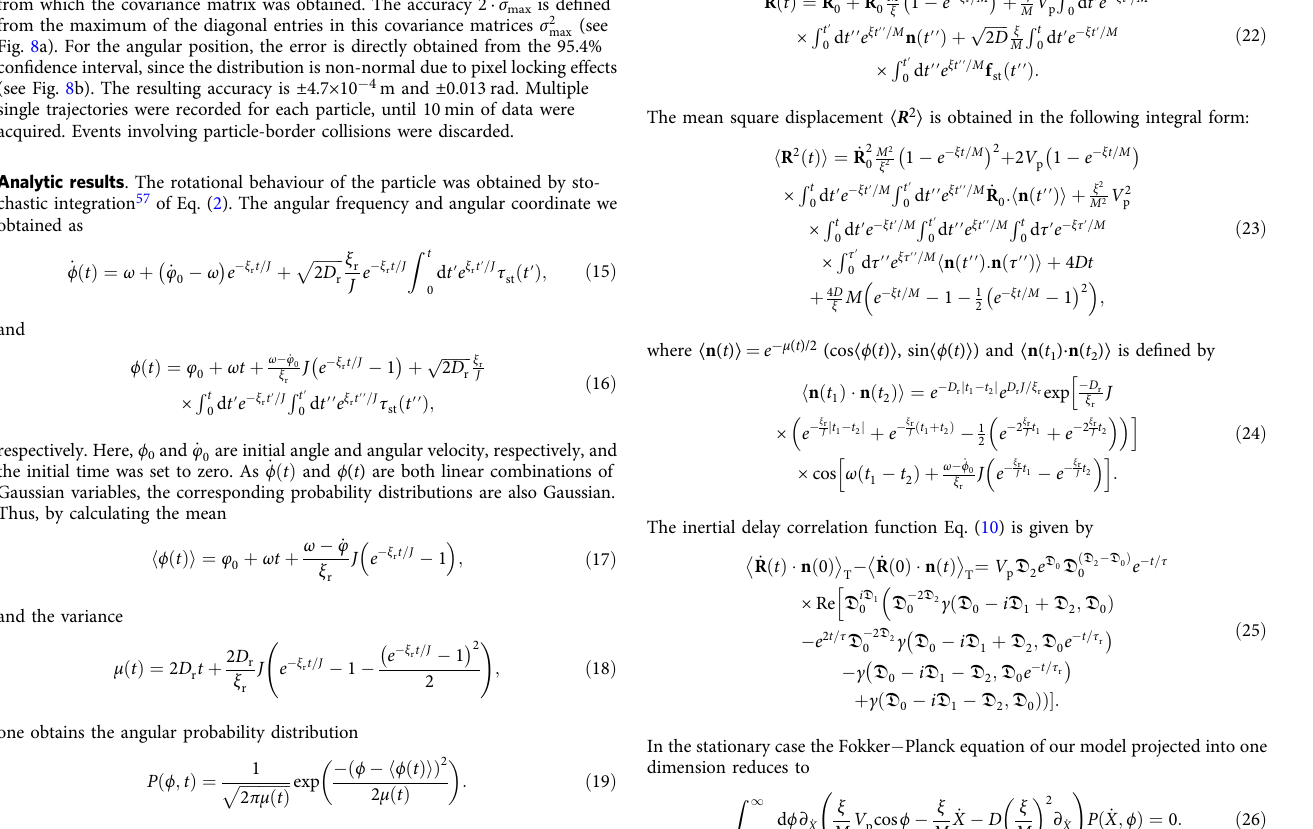
Experimental setup . The vibrobots were excited by vertical vibrations generated by a circular acrylic baseplate (diameter 300 mm, thickness 15 mm) attached to an electromagnetic shaker (Tira TV 51140) and surrounded by a barrier to con fi ne the particles. The tilt of the plate was adjusted with an accuracy of 0.01°. The vibration frequency and amplitude was set to f = 80Hz and A = 66(4) μ m, respectively, guaranteeing stable excitation with peak accelerations of 1.7(1) g (measured by four LIS3DH accelerometers). To ensure homogeneous excitation, the acceleration amplitude was measured at different radial and azimuthal positions in steps of 3cm and 45° respectively, at constant frequency. The variation of amplitudes at a mean acceleration of 1.7 g is below 5% (see Fig. 7a, b). To ensure that no other factors signi fi cantly affect the isotropy of the system, the average particle velocity was measured as a function of the radial distance to the centre (Fig. 7c). The resulting fl uctuations are small compared to the mean (standard deviation lies between 1.8 and 3.6% of the respective mean). Experiments were recorded using a high-speed camera system (Allied Vision Mako-U130B) operating at up to 152 fps with a spatial resolution of 1024 × 1024 pixels. Single particles were tracked to sub-pixel accuracy using standard image recognition methods. The tracking accuracy was determined from test measurements of a particle rigidly attached to the plate at different locations. A bivariate Gaussian distribution was fi tted to the positions, from which the covariance matrix was obtained. The accuracy 2 · σ max is de fi ned